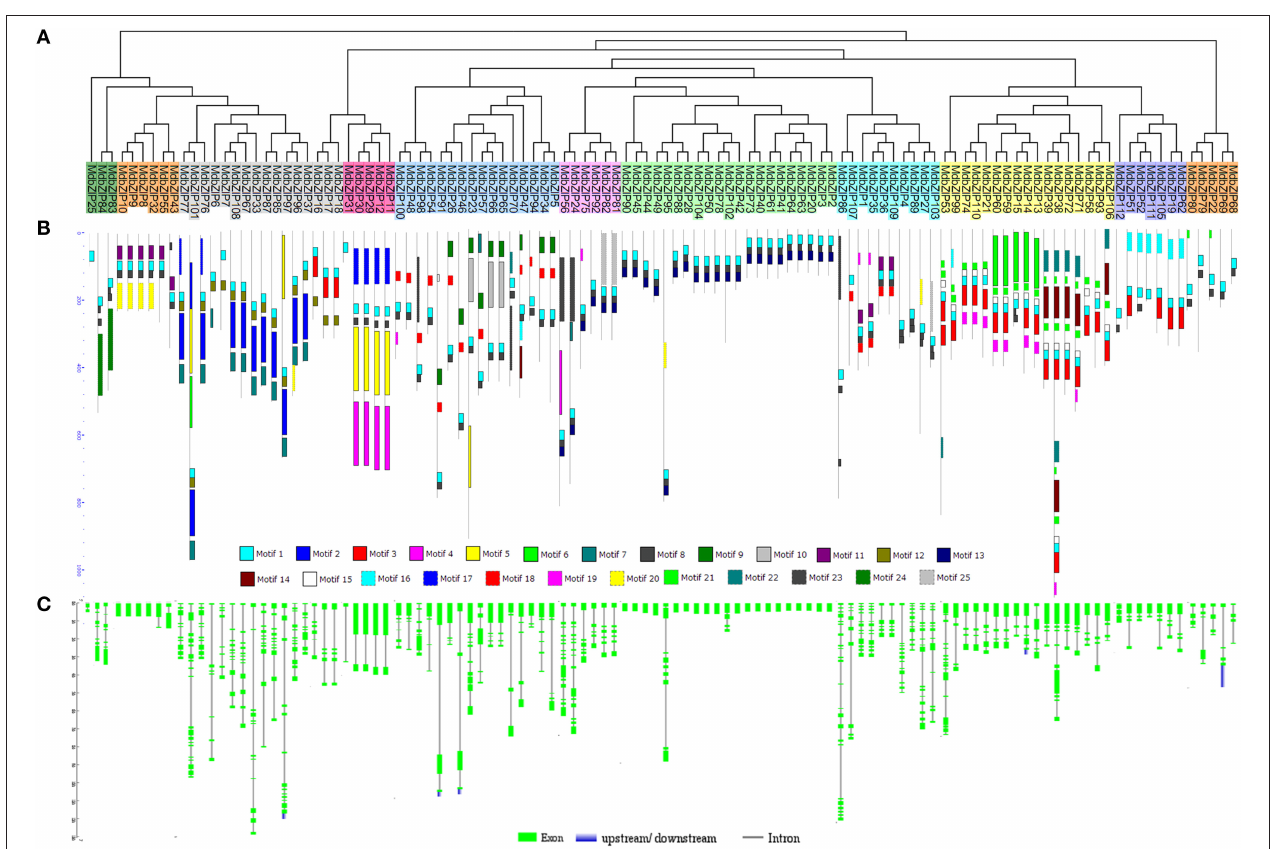
FIGURE 3 | Characterization of apple bZIP genes. (A) Phylogenetic analysis of apple MdbZIP proteins. (B) Distribution of conserved motifs identified in the 112 MdbZIP proteins. Each motif is represented by a number in a colored box. See Supplementary Table S3 for detailed information regarding the motifs. (C) Exon/intron structure of apple bZIP genes, green indicates exons; black indicates introns; blue indicates upstream or